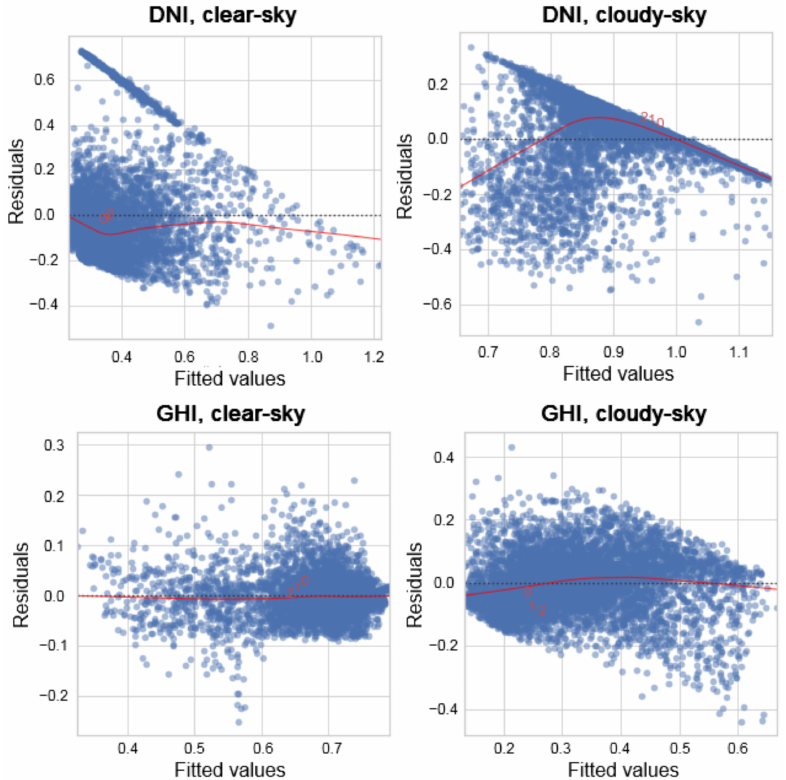
Figure 10. Residual plots for DNI and GHI cases, which show scatter plots between residuals and the fitted values from MLR. The red smooth curve indicates the fitting of the